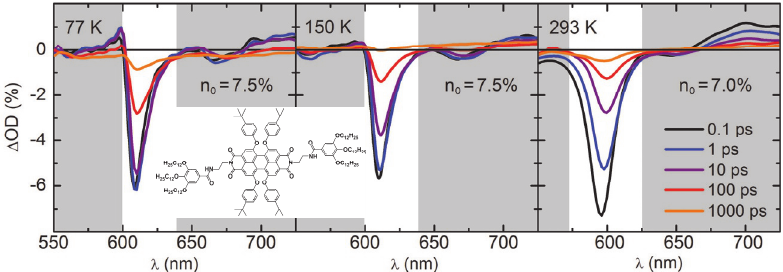
Fig. 1. Transient absorption spectra of PBI-1 aggregates after optical excitation at 530 nm for different sample temperatures. n 0 denotes the optically generated exciton density per